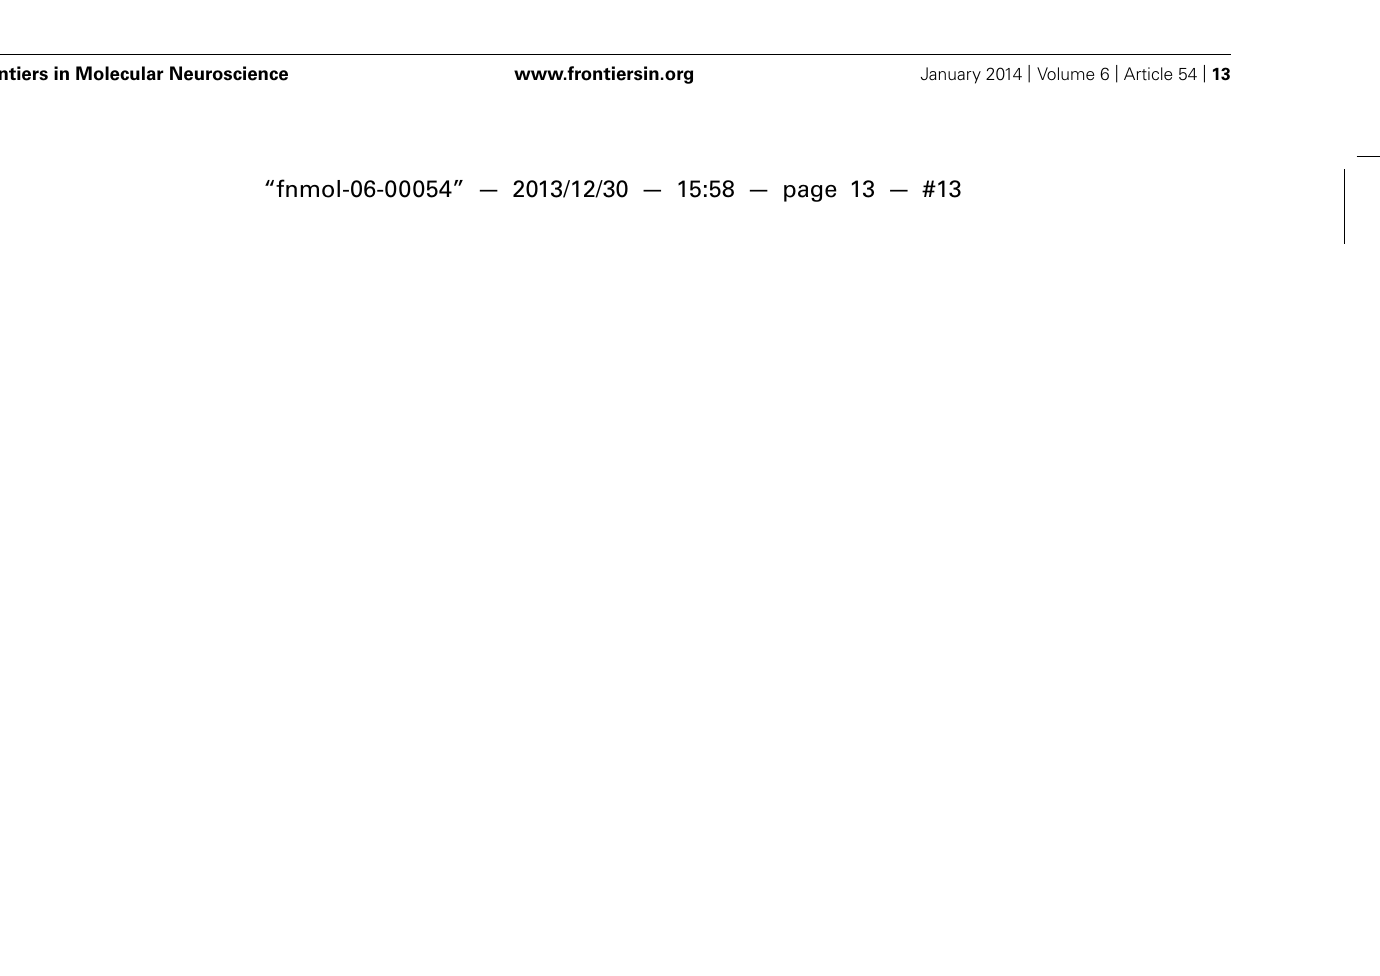
(C) Cumulative frequency distributions indicate specific changes in spine head areas. In the absence of PI3K activation, persistent spines (closed circles) suffer a reduction of spine head when compared to control values (open circles), mostly affecting sizes below 1.0 μ m (Kolmogorov–Smirnov, p < 0.001).The de novo spines (gray circles) exhibited smaller areas (statistically different from controls; Kolmogorov–Smirnov, p < 0.01), preferentially affecting spines larger than 0.4 μ m. After PI3K treatment, the full range of spine size is affected and both distributions are characterized by the presence of small spines size population ( de novo : yellow circles; persistent: red circles; Kolmogorov–Smirnov, p <